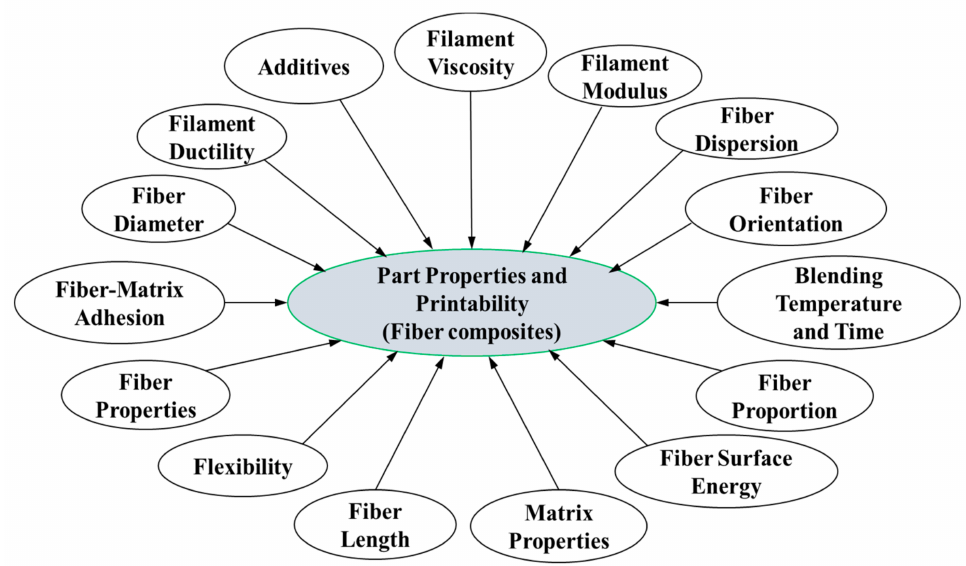
Figure 7. The factors affecting part properties and printability of fiber composite